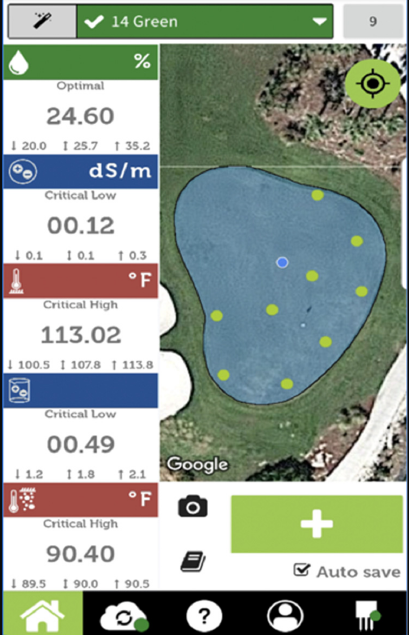
Figure 2. The POGO TurfPro (Stevens Water Monitoring Systems; Portland, OR, USA) utilizes a bluetooth-linked mobile application (TurfPro Mobile) for data collection and analysis. This is an example of a data collection and analysis output from green #14 on a golf course. The image indicates the perimeter of the site (i.e., putting green), the location of all nine sampling sites withing that putting green, soil moisture (percent volumetric water content), soil electrical conductivity (dS·m − 1 ), surface temperature (as °C or °F), salinity concentration index (dS·m − 1 ), and root zone temperature (as °C or °F).